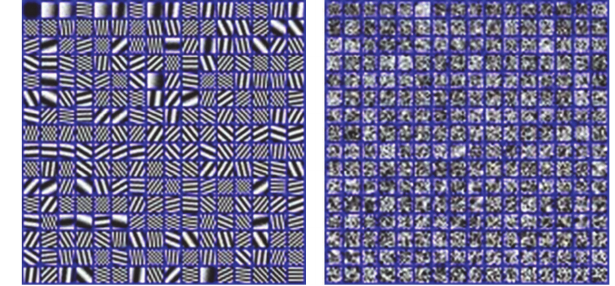
Figure 4: The DCT dictionary and the trained